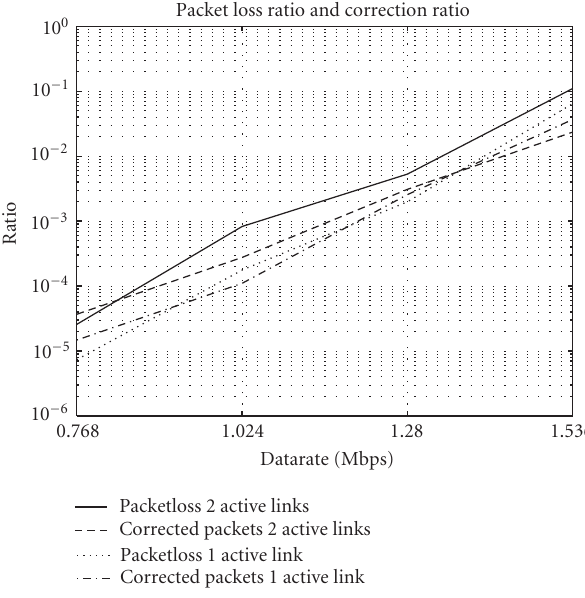
Figure 8: Measured packet loss ratio and packet correction